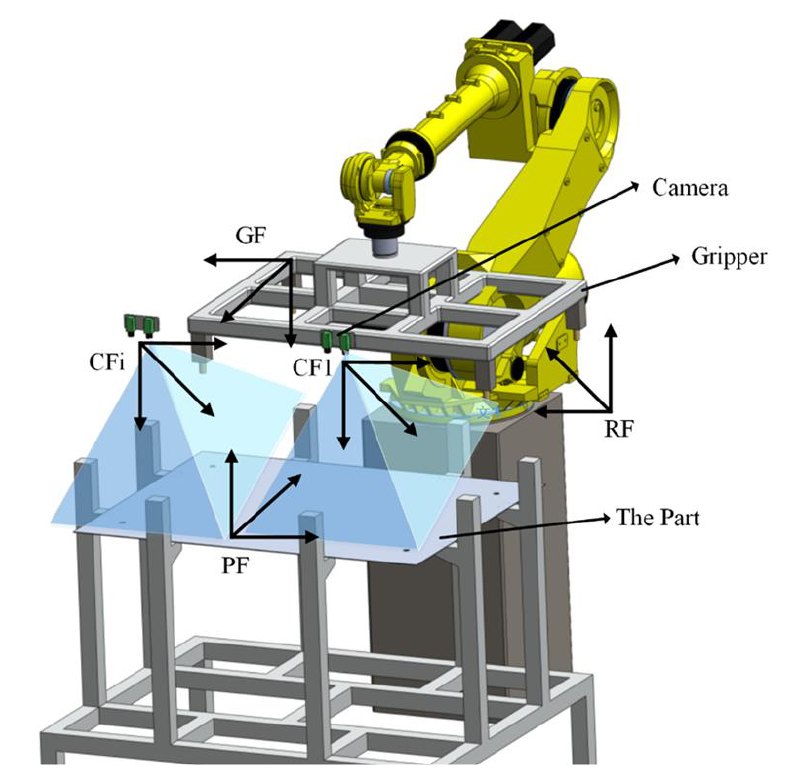
Figure 1. The coordinate systems of the robotic intelligent grasping system consist of robot frame ( RF ), parts frame ( PF ), robot gripper frame ( GF ) and camera frame ( CF ).